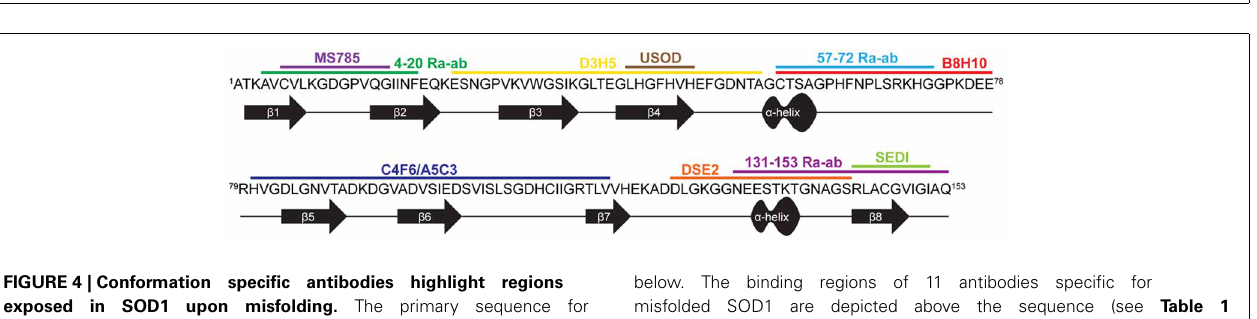
below. The binding regions of 11 antibodies specific for misfolded SOD1 are depicted above the sequence (see Table 1 for antibody